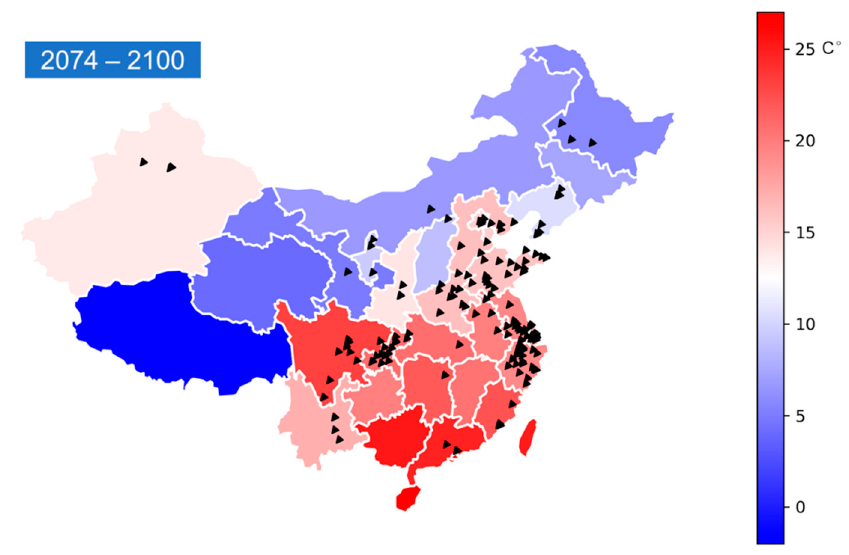
Figure A4. Annual average temperature levels in long-term future (2074–2100), and locations of wastewater treatment plants included in the sample.